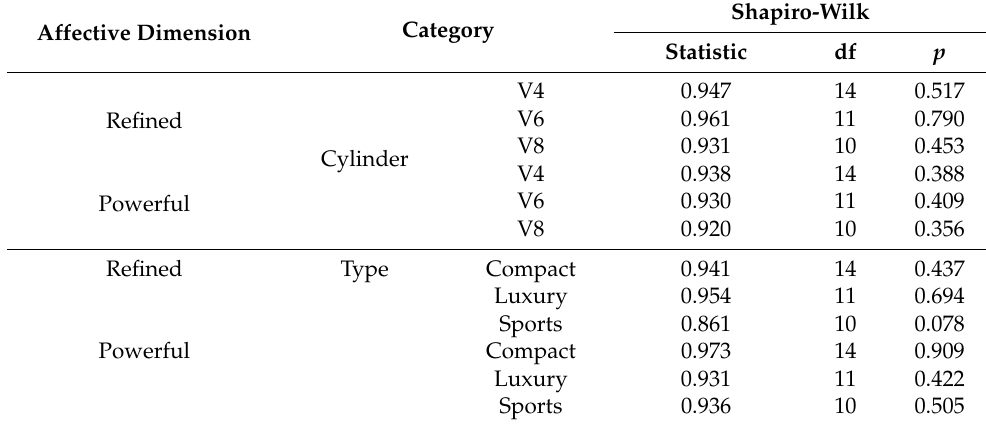
Table 5. Results for tests of normality.